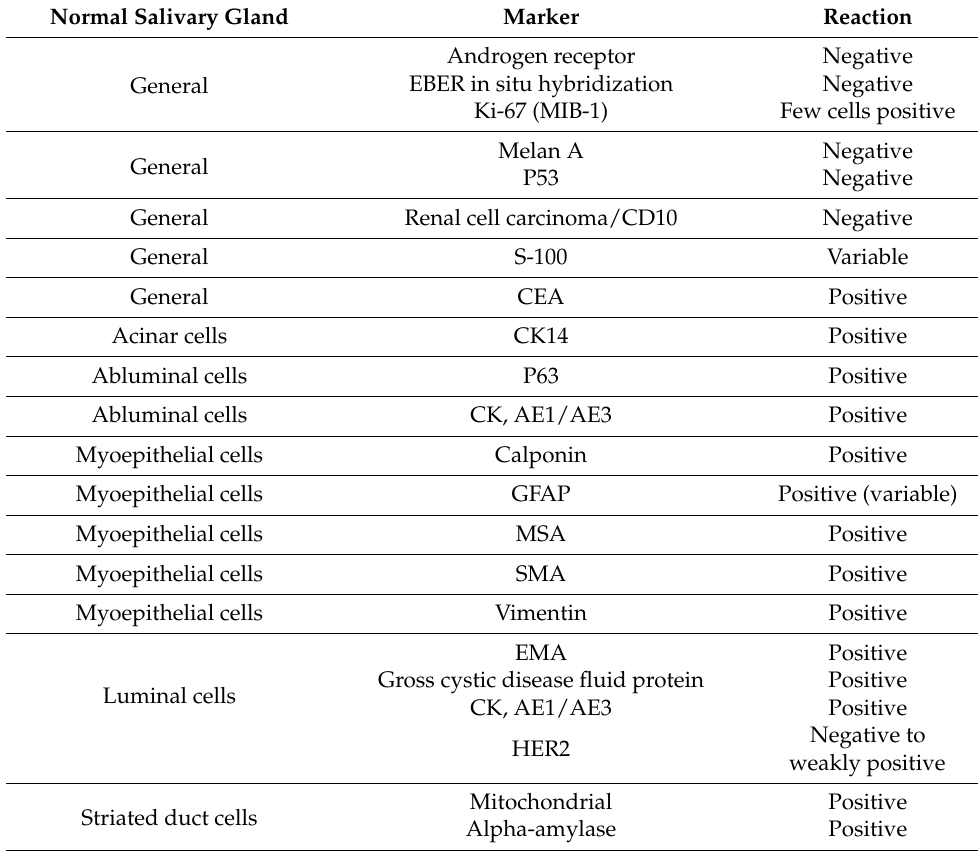
Table 1. Normal salivary